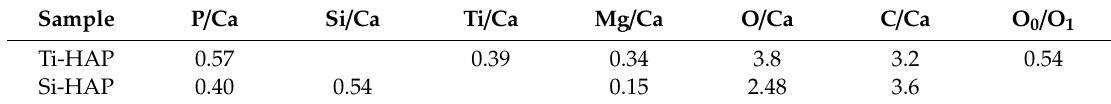
Table 3. Measured atomic ratios of investigated